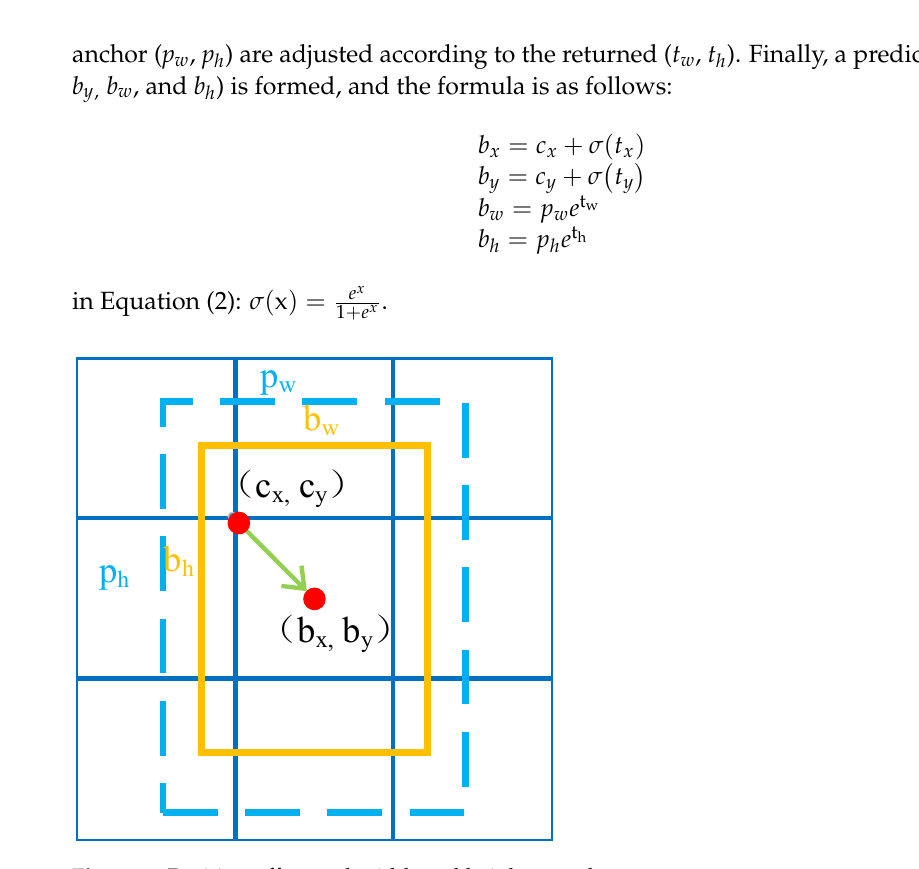
Figure 2. Position offset and width and height stretch.